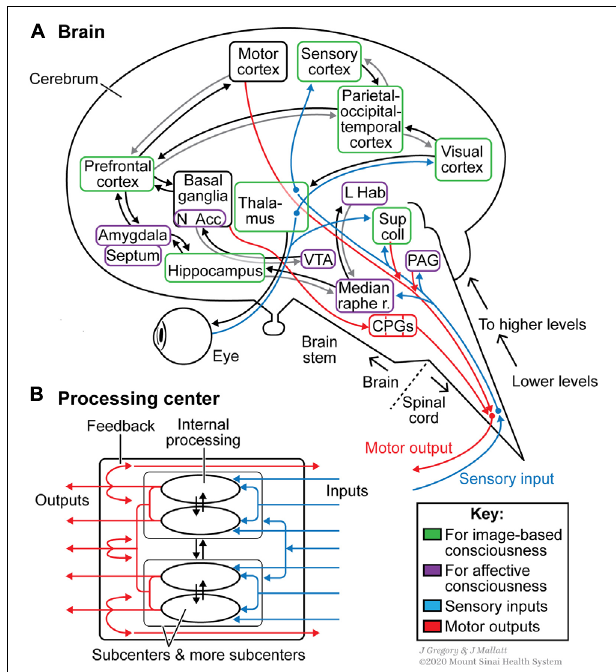
FIGURE 3 | Some special neurobiological features of conscious systems, shown by the human brain and nervous system. These features include elaborate sensory organs (e.g. eye), neural hierarchical levels from the spinal cord upward, extensive reciprocal communication between neural processing centers (the rectangular boxes and the connecting arrows), and processing centers for image-based versus affective consciousness (green versus purple boxes). For more, see Table 2 , Level 3 . (A) Consciousness relies on processing centers that are widely distributed but integrated. While neural processing goes on within the centers, communication also occurs among the centers, leading to both local functional specialization and global coherence. (B) Schematic drawing showing processing within a center. The center has subcenters for subprocessing operations that are subsequently integrated to produce the center’s outputs. Abbreviations in (A) are CPGs: central pattern generators for various stereotyped movements; L Hab: lateral habenula; Median raphe r.: median raphe region of the reticular formation; N Acc: nucleus accumbens; PAG: periaqueductal gray; Sup coll: superior colliculus (optic tectum) of midbrain; VTA: ventral tegmental area of the midbrain. Figure © Mount Sinai School of Medicine.